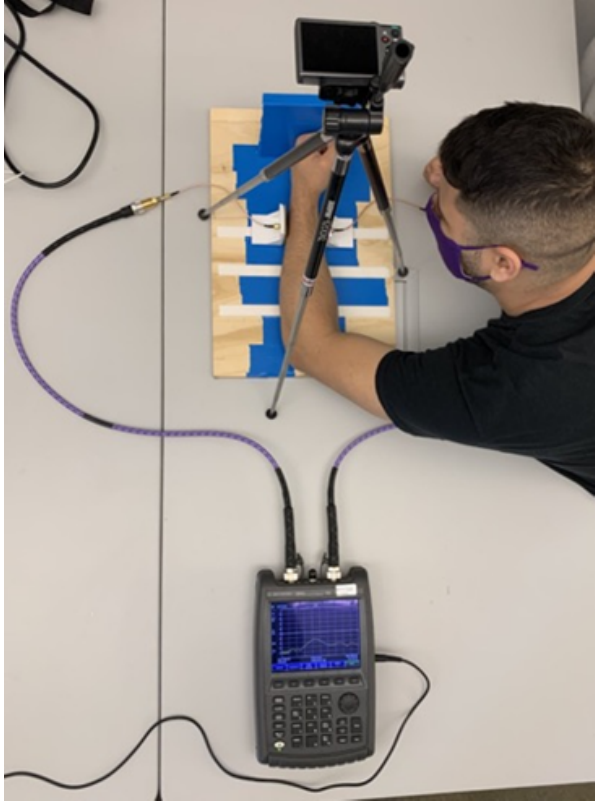
Figure 5. Experimental setup used to obtain S21 measurements from the